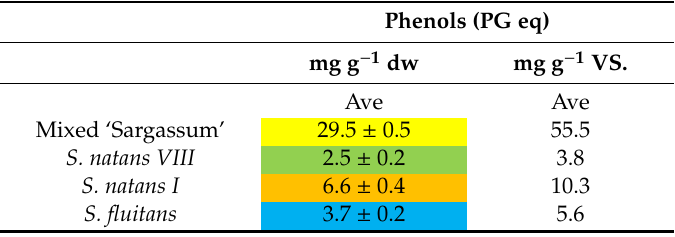
Table 6. The total phenolic content results expressed in mg phloroglucinol equivalent (PG eq) per gram of dry matter ( n ≥ 3) and per gram of VS. di ff erences in colour within a column indicate statistically significant di ff erences between samples ( p <